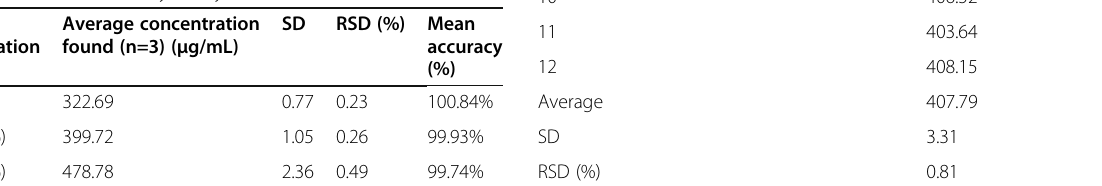
Table 4 Results of accuracy study